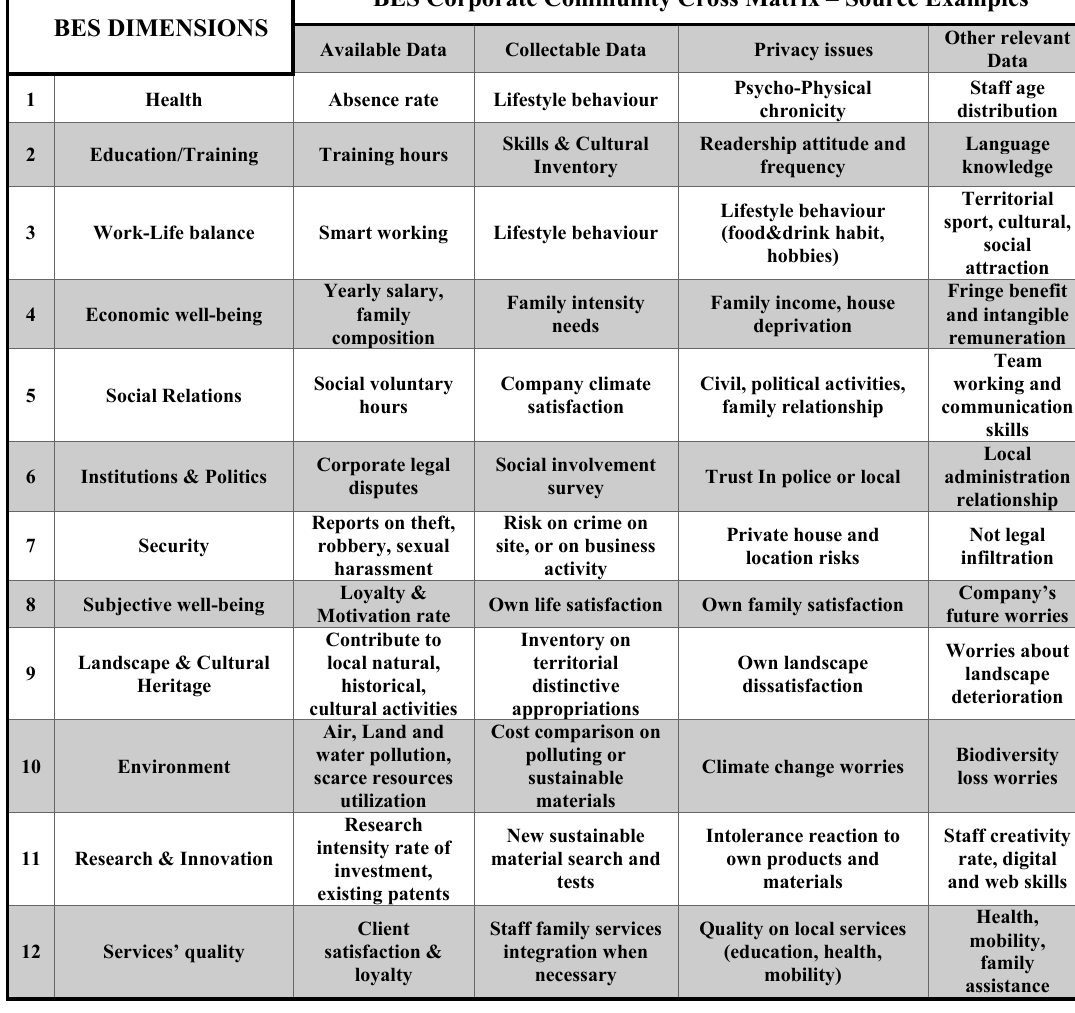
Table 2 : The BES Corporate Community Cross Matrix BES